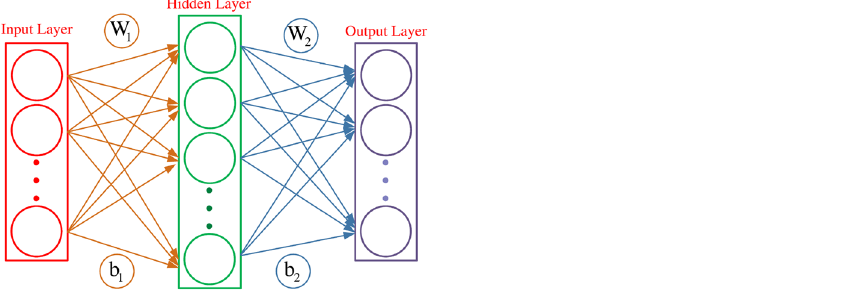
The size of training sets